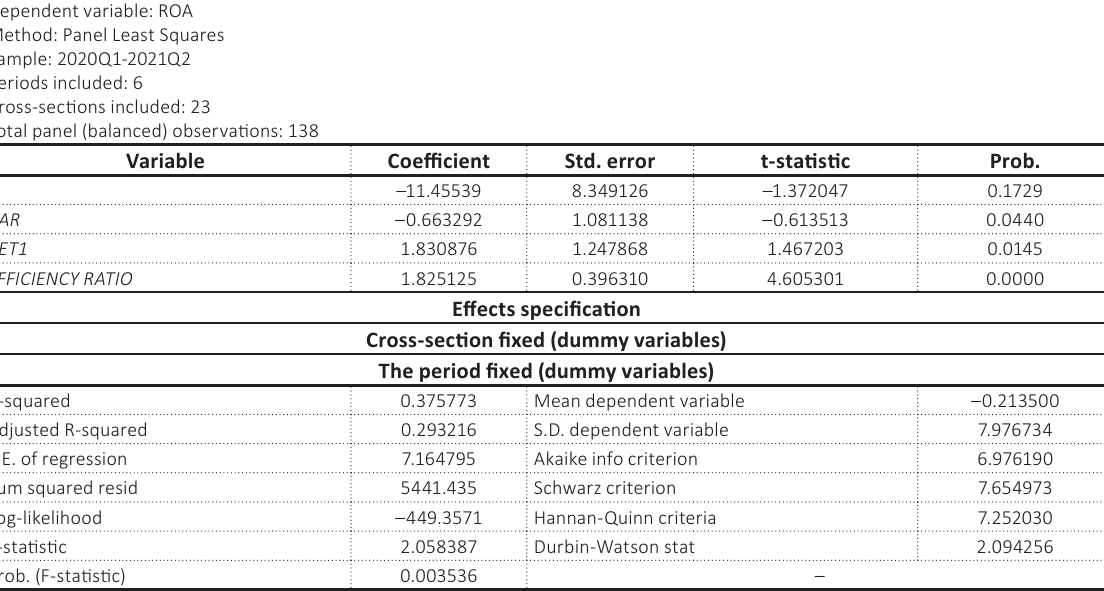
Table 3. Formulation of fixed effect panel regression model for